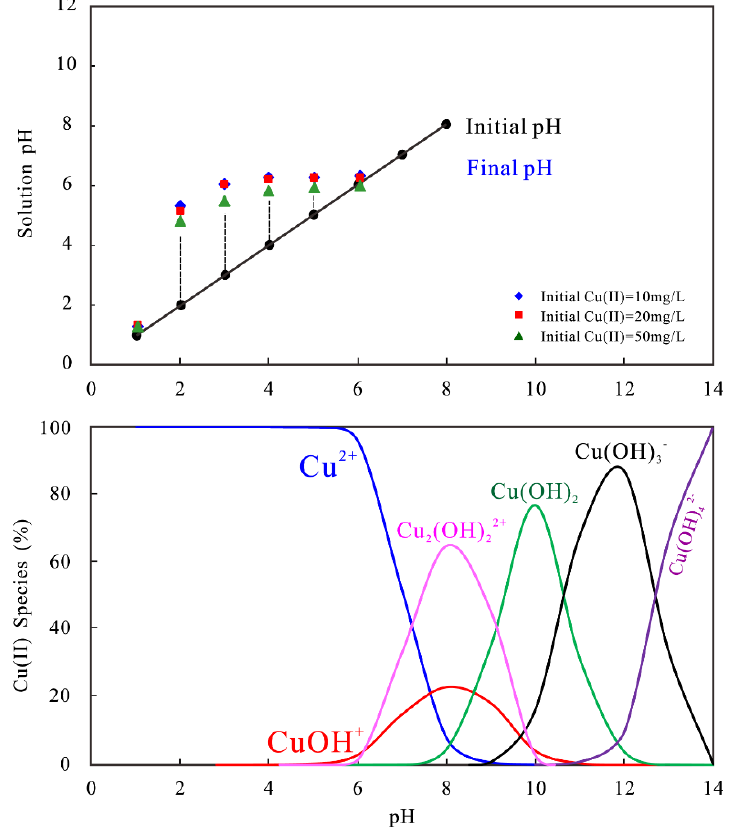
Figure 13. Change of the solution pH during Cu (II) removal by SC–HA/C.